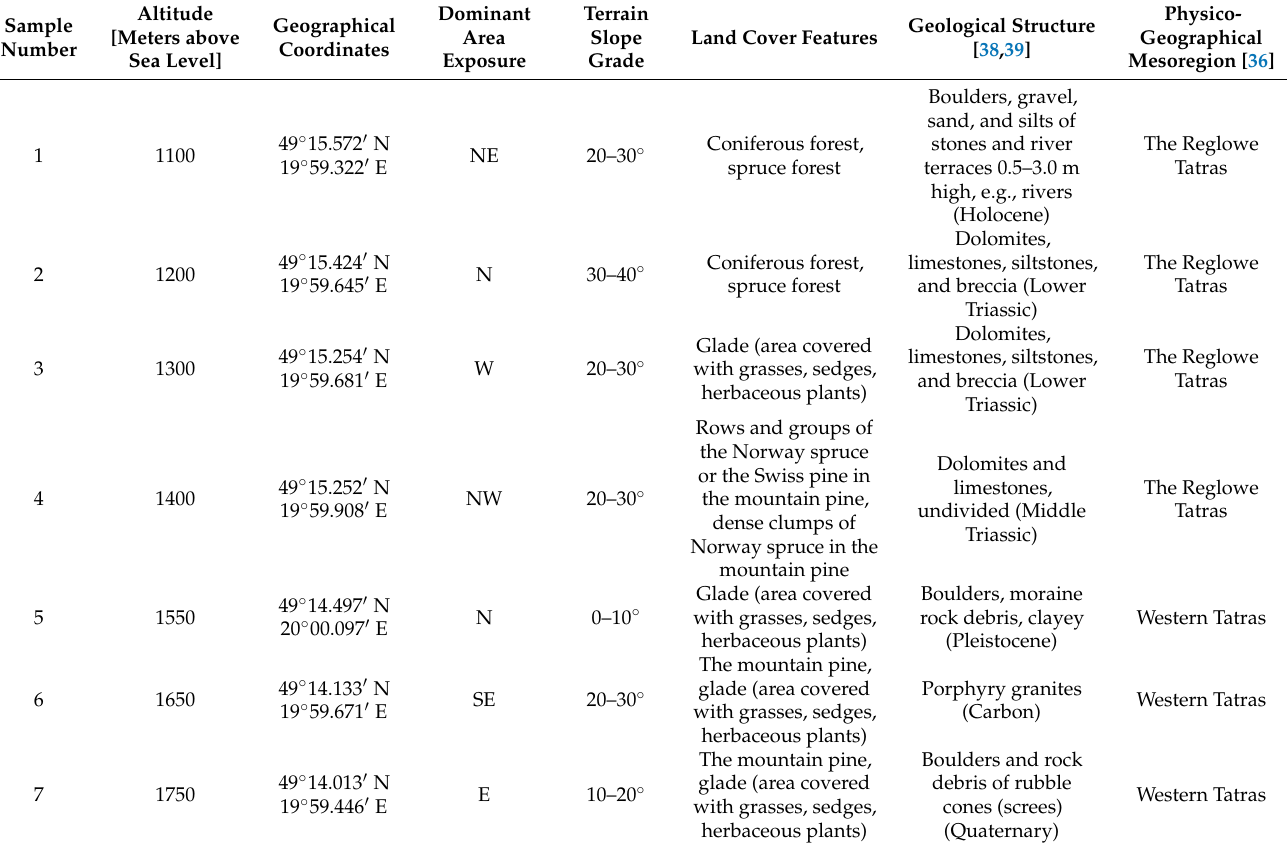
Table 1. Characteristics of sampling points in the Kasprowy Wierch test area